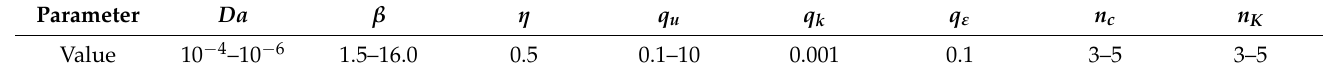
Table 2. Parameters used in the 2D topology optimization process.